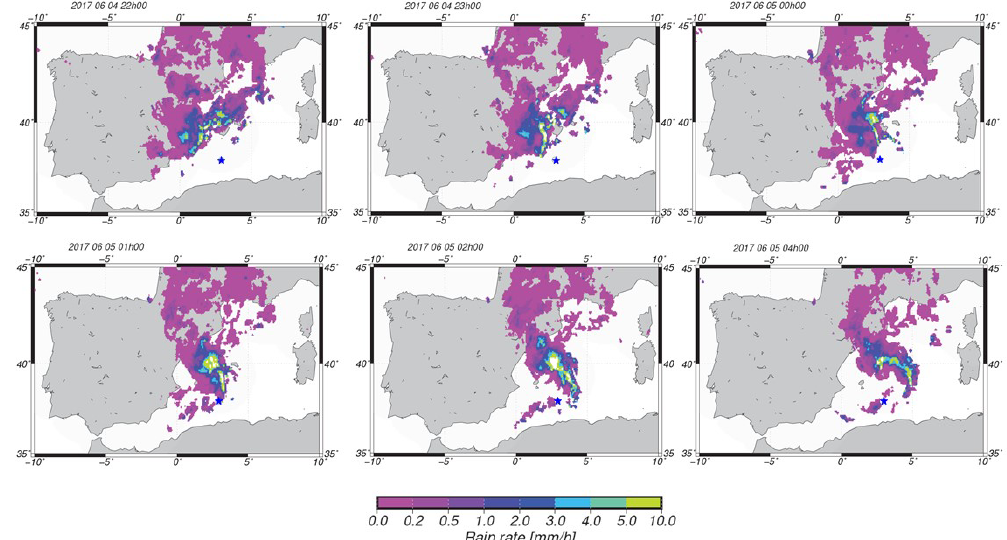
Figure 5. Rain rate (mmh − 1 ) during the night between 4 and 5 June (blue star is the position of the FAST station). These European radar composite products were provided by the Odyssey system, created in the framework of the Opera program that is the radar component of the Eumetnet observation program.